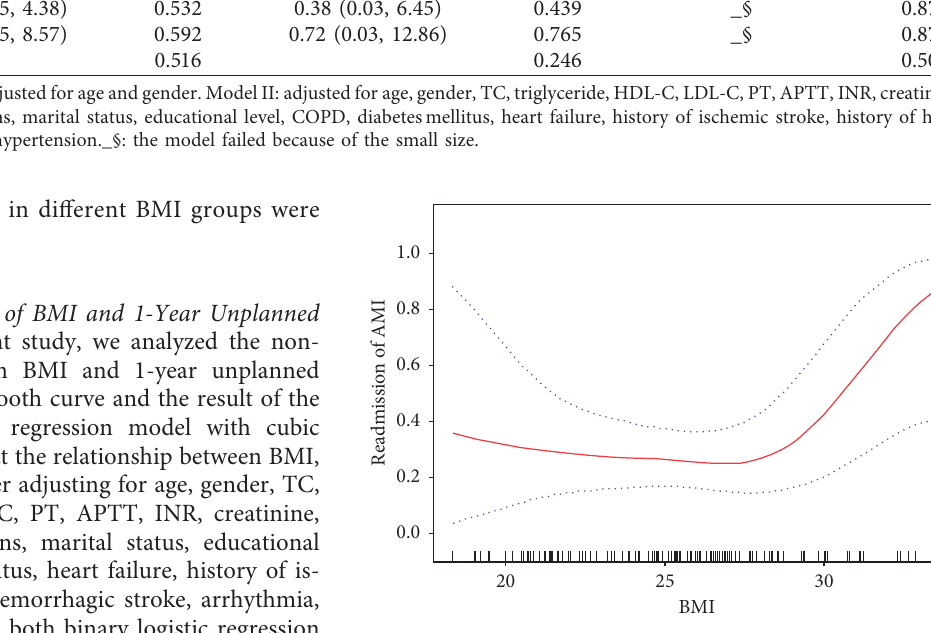
Figure 2: Association between BMI and readmission of AMI. A threshold, nonlinear association between BMI and readmission of AMI was found ( P � 0 . 022) in a generalized additive model (GAM). Solid rad line represents the smooth curve fit between variables. Blue bands represent the 95% of confidence interval from the fit, all adjusted for age, gender, TC, triglyceride, HDL-C, LDL- C, PT, APTT, INR, creatinine, HGB, LVEF, discharge medications, marital status, educational level, COPD, diabetes mellitus, heart failure, history of ischemic stroke, history of hemorrhagic stroke, arrhythmia, and hypertension.